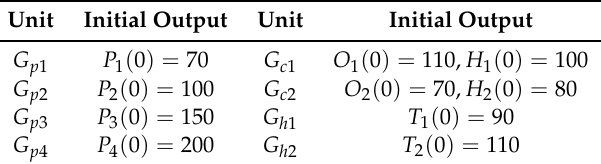
Table A7. The initial output parameters of different